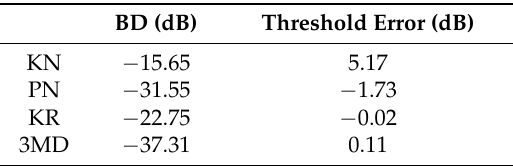
Table 5. Goodness of fit metrics for the models in Figure 7. Threshold error is measured at a CCDF of 10 − 4 .